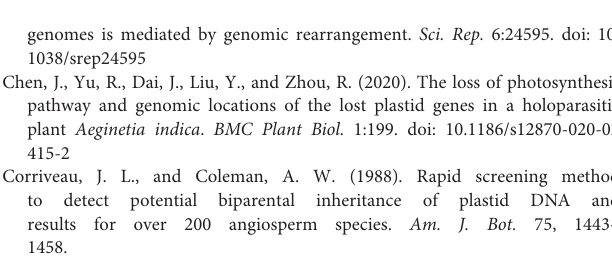
Supplementary Figure 1 | Gene map of the Zingiberaceae chloroplast genomes. Dashed area in the inner circle indicates the GC content of the chloroplast genome. Supplementary Figure 2 | MAUVE alignment of Zingiberaceae chloroplast genomes. Supplementary Figure 3 | Percentage of variable characters in aligned protein-coding regions of the chloroplast genomes. Supplementary Figure 4 | Average amino acid use frequency of chloroplast genomes in Zingiberaceae. Supplementary Figure 5 | Comparative analysis of nucleotide diversity in protein-coding regions of four species: (A) R. tibetica - C. gracilis ; (B) P. lackneri - R. beesianus ; (C) R. tibetica - P. lackneri ; (D) R. tibetica - P. lackneri ; (E) C. gracilis - P. lackneri ; (F) C. gracilis - R. beesianus